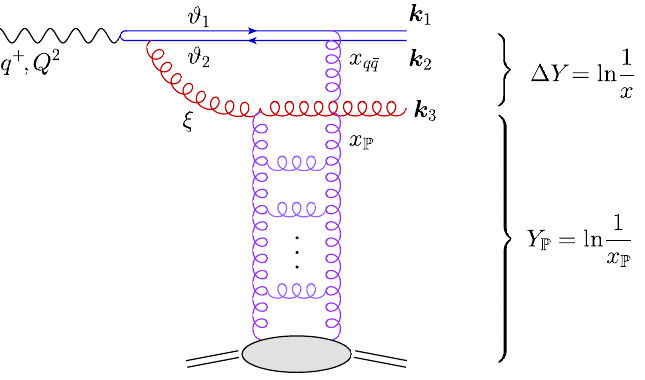
Figure 1 . Schematic representation of a Feynman graph contributing to diffractive trijet production. The colourless, “Pomeron”, exchange is represented by the gluon